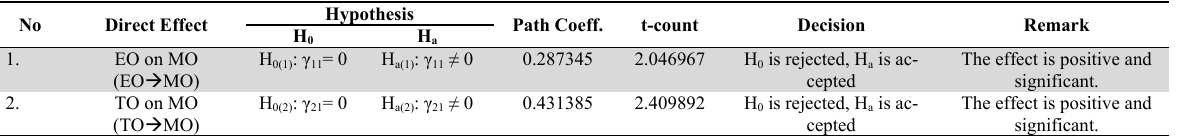
Summary of t-count results from direct effect test